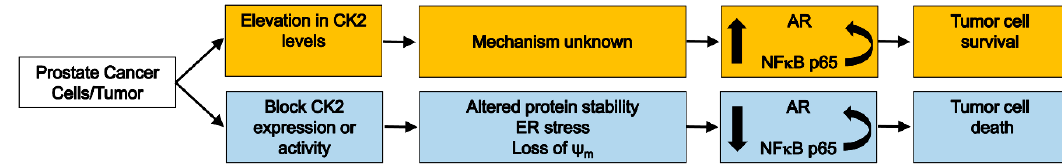
Figure 9. Cartoon summary of the influence of CK2 expression and activity on AR and NF κ B p65 protein expression and prostate tumor cell survival as described in this work.